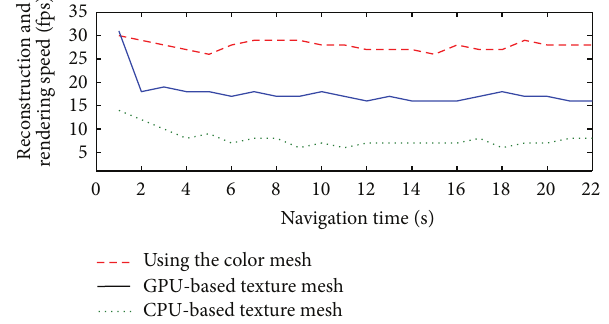
Figure17:Speedperformancecomparisonofterrainreconstruction and rendering processes using the color mesh, GPU-based, and CPU-based